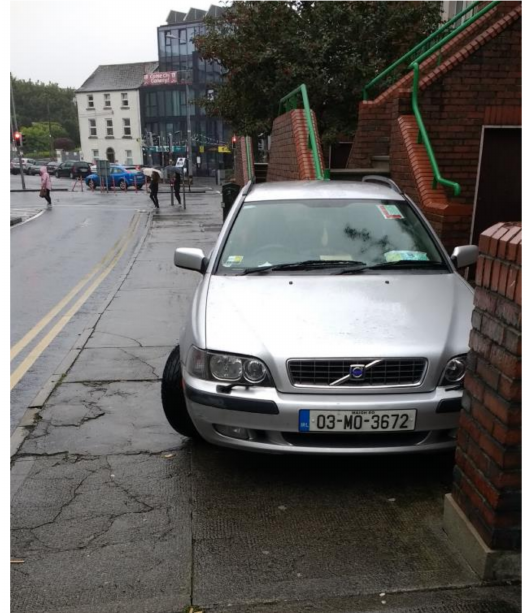
Figure 11. Forster Street,